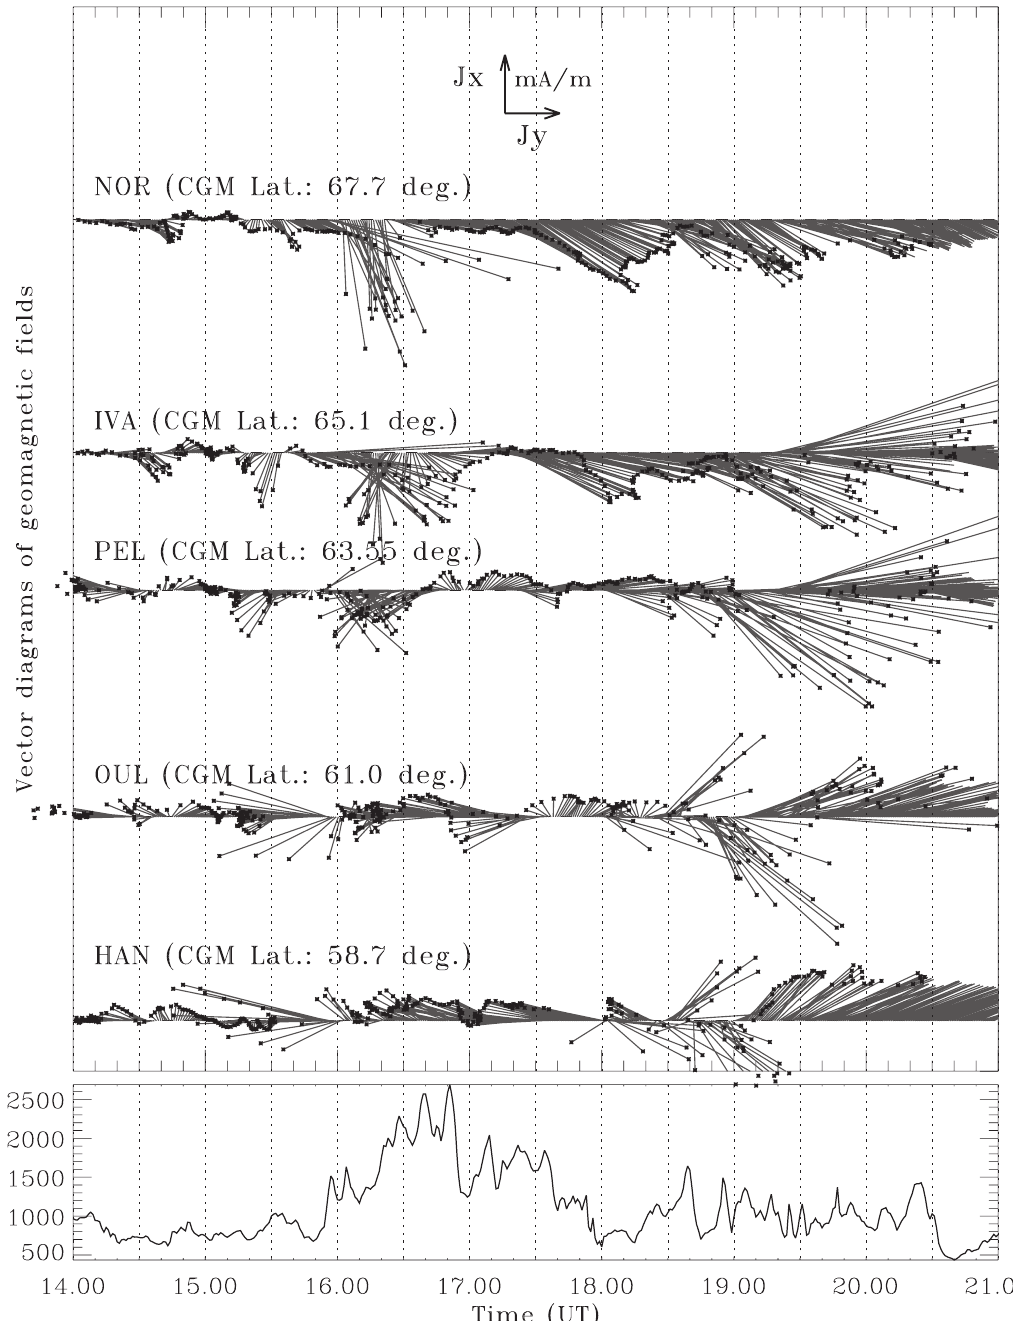
Fig. 9. Vector diagrams of the equivalent currents J along the meridional pro fi le between 14 UT and 21 UT on 17 March 2013 (time step 1 min). The bottom panel shows the 1-min AE index